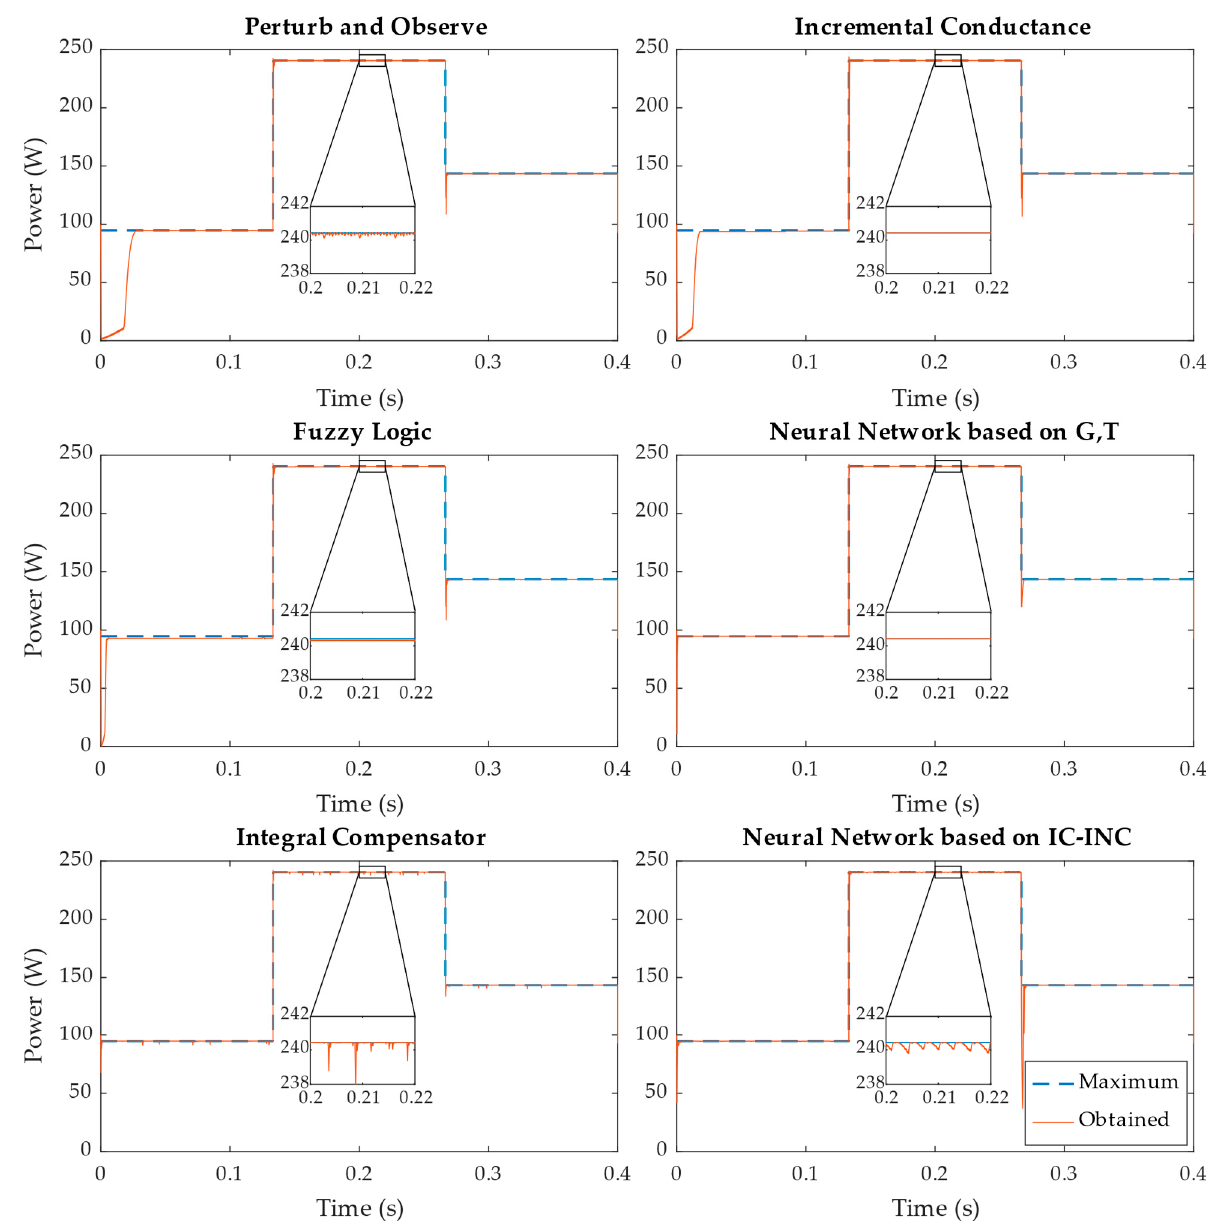
Figure 13. Simulation results of power produced from panel when step variations occurred.